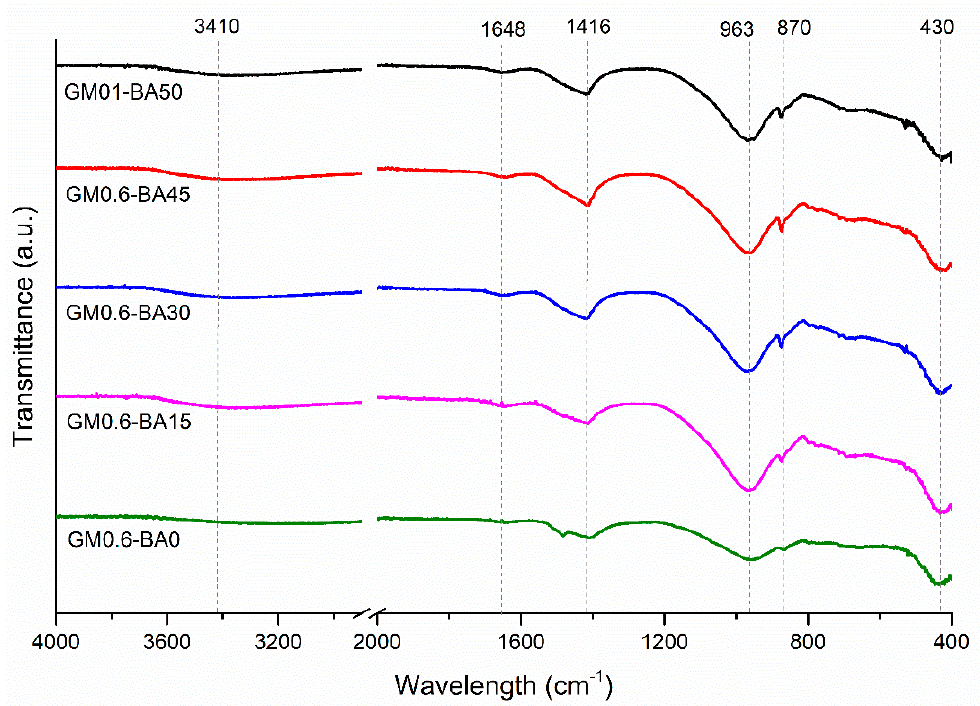
Figure 5. FTIR spectra for pastes after 28 days of curing.